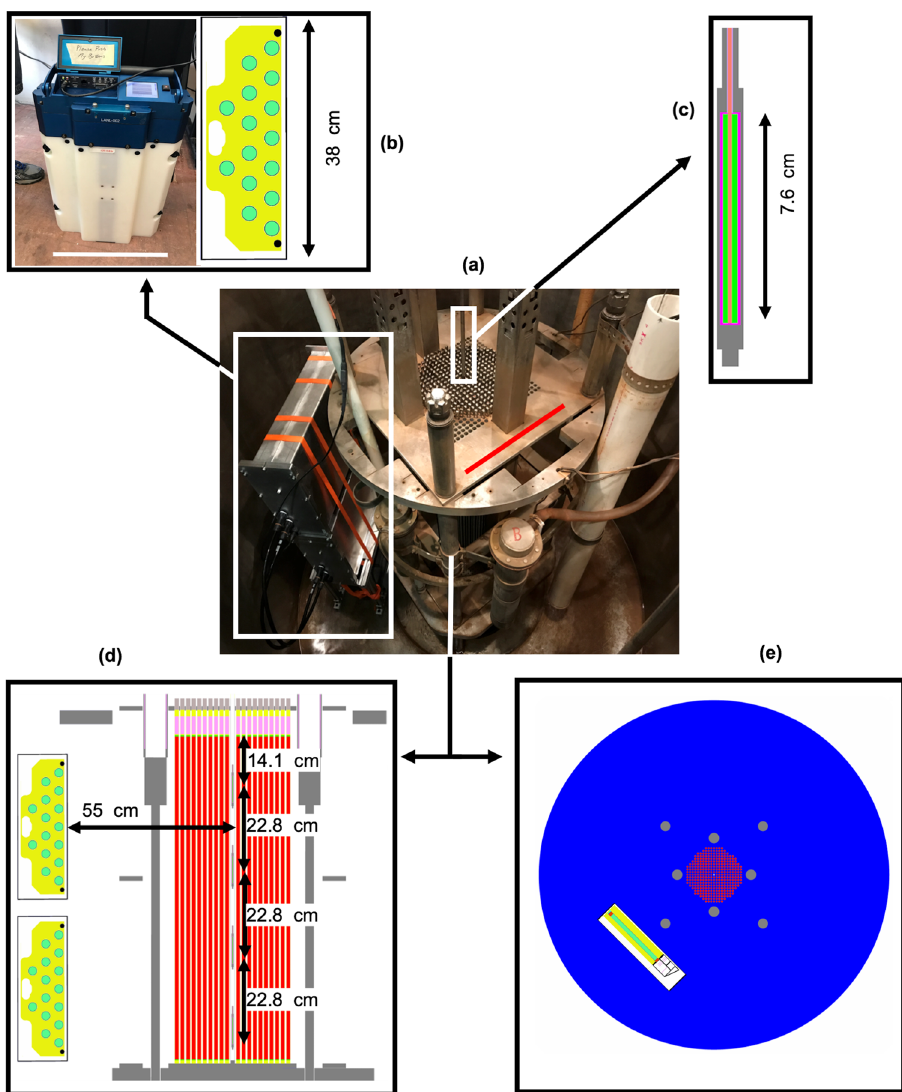
Fig. 1 Experimental setup of the Reactor Critical Facility (RCF) experiments to characterize fl uctuations and correlations. a Top view of the RCF nuclear reactor, with two neutron multiplicity 3 He array detectors (NoMAD) in their water-proof cases on the left side. The red scale bar is 34 cm long. b The NoMAD detectors are made of 15 3 He tubes (left: picture with a 38 cm white scale bar, right: MORET6 (Monte Carlo neutron transport code) modeling of a NoMAD detector out of its case, where the 3 He tubes appear in green). The positioning of these detectors just next to the reactor allows to reconstruct the axial power distribution up to reactor power close to 10 mW, avoiding dead time and saturation effects. c MORET6 modeling of one of the four identical 3 He tubes positioned within a “ detector ” pincell placed in the center of the reactor so as to reconstruct the axial power distribution directly within the reactor, up to a power of 2 mW. d , e Side view and top view, respectively, of the reactor and the detectors, modeled using MORET6. On panel d , the vertical fuel rods appear in orange and the structural materials and the control rods appear in gray. During operation, the reactor is immersed in water (which appears in blue, in panel e ffiffiffiffiffi q Λ D . The tran- ρ sition between these qualitatively different asymptotic average neutron concentrations occurs at ρ = 0, which de fi nes the criti- cality condition for the reactor. In the case of the RCF reactor, above about P = 1 W, the average neutron population exhibits the cosine shape, while below about P = 10 mW it is driven by spontaneous fi ssions and the spatial shape obeys Eq. (2).